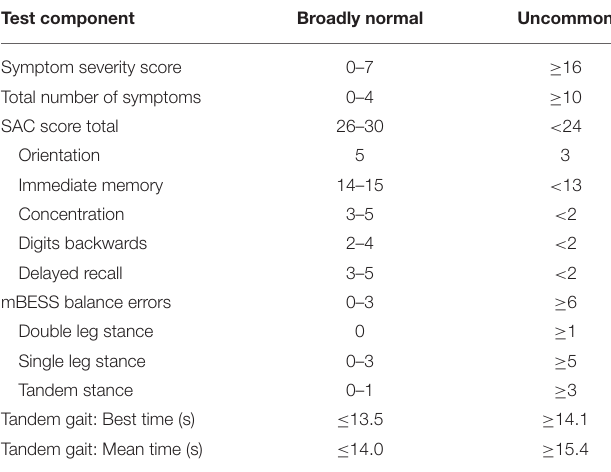
TABLE 6 | SCAT5 quick reference guide for clinicians (for women who are professional rugby league players). Test